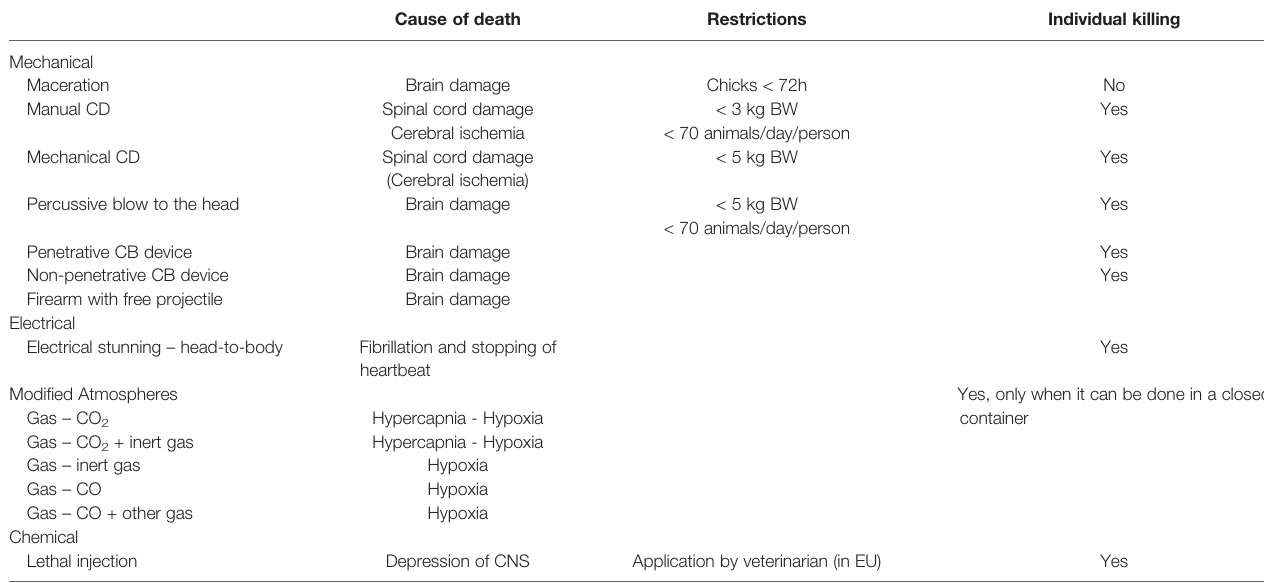
TABLE 1 | Killing methods allowed for poultry, with indication of cause of death, restrictions on using the method regarding maximum body weight of the birds (BW), or maximum number of birds that may be killed per day per person, and whether or not the method is suitable for killing individual birds (as opposed to killing of entire fl ocks) (European Union, 2009; HSA, 2016; EFSA,